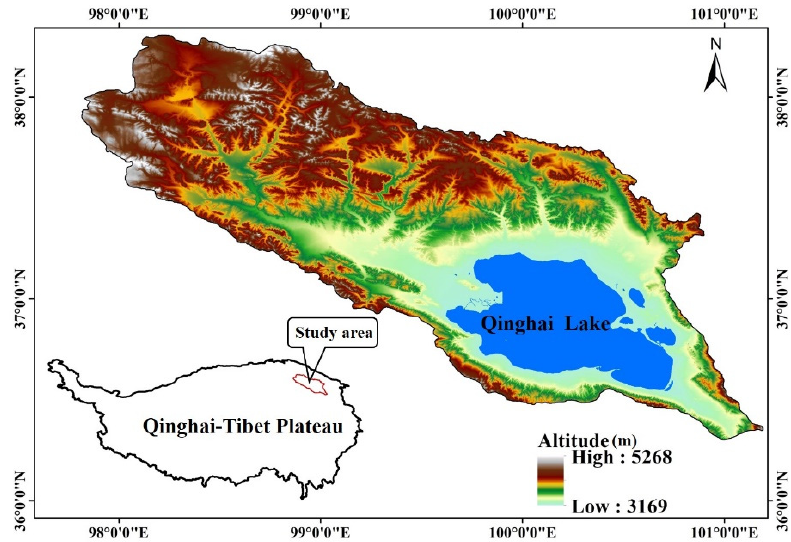
Figure 1. Location of the Qinghai Lake Basin.